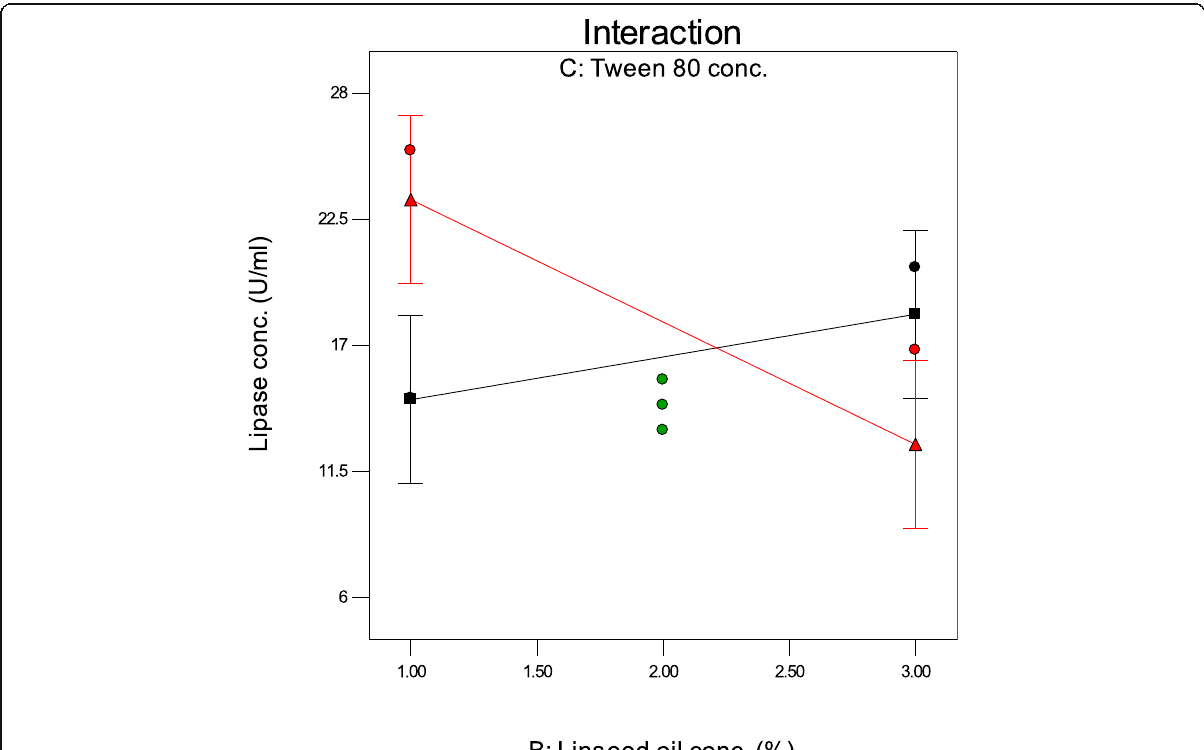
Fig. 7 The effect of linseed oil concentration on lipase production at Tween-80 levels of 0.0 g/l (black-colored line) and 4.0 g/l (red-colored line). Bars on the plot represent the least significant difference